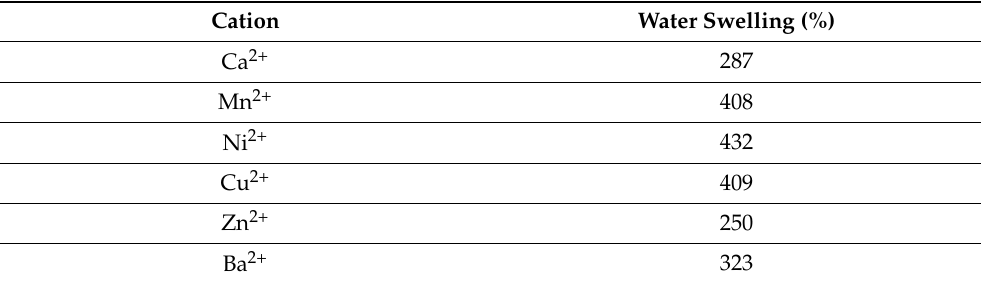
Table 1. Water swelling of alginate hydrogels stabilized by divalent